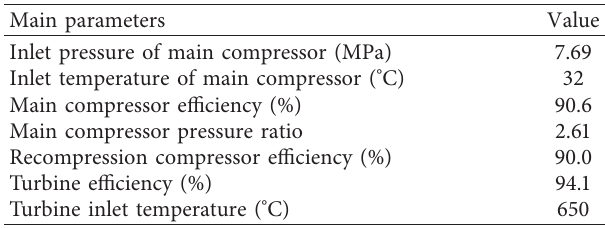
Table 2: Cycle design parameters of MIT 2400MW pression Brayton cycle.